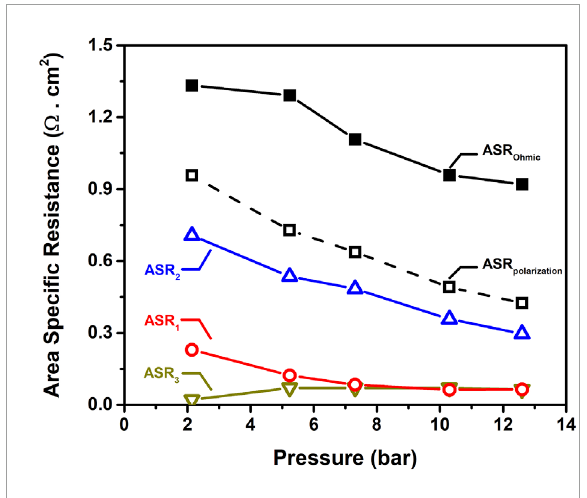
FIGURE 4 Effect of operating pressure on area-specific resistance.